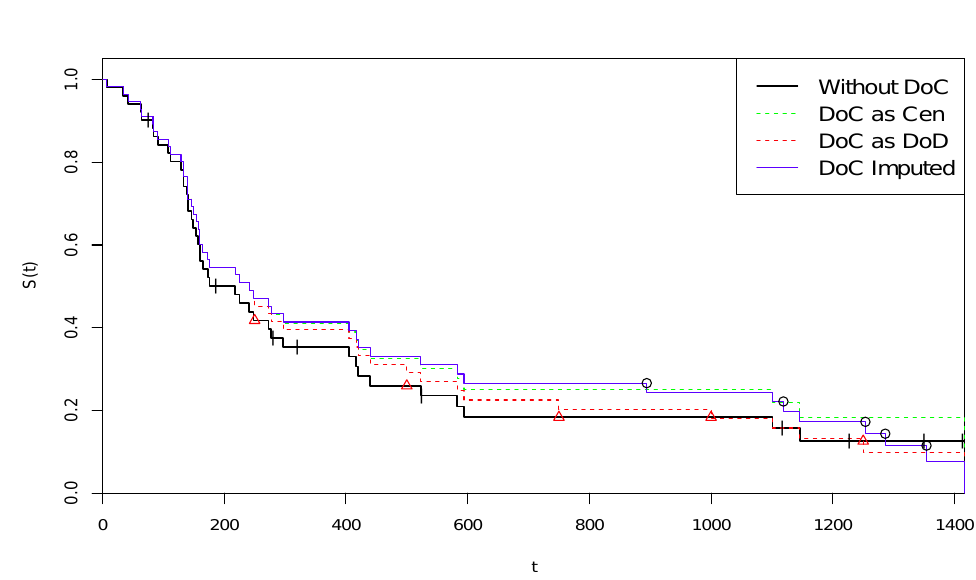
Figure 1. Kaplan–Meier curves for alternative treatments of COVID-19 deaths—Arm